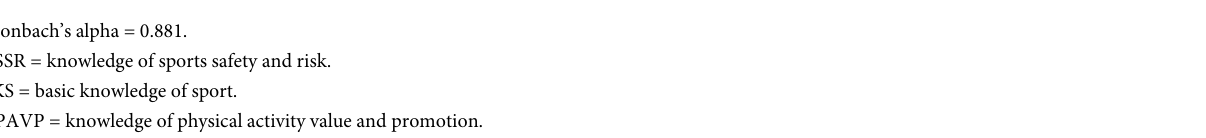
not necessarily hinder the development of PL, but may benefit from the collision of ideas between scholars of different languages, cultures, and regions. Conversations about PL need to be more inclusive in the world.